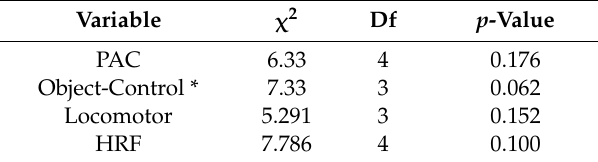
Table 3. Measurement invariance for latent